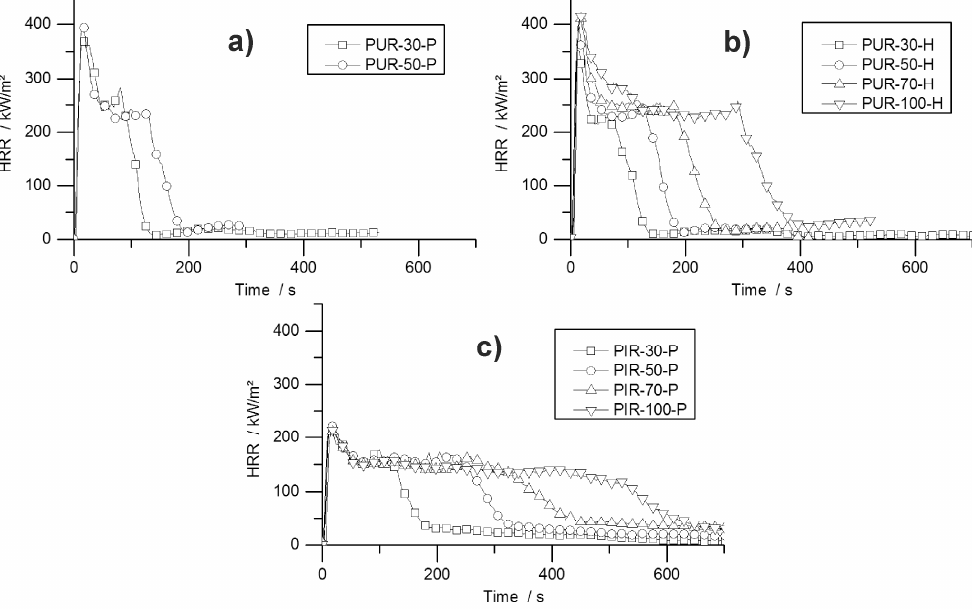
Figure 4. HRR curves for ( a ) pentane-blown PUR, ( b ) water-blown PUR, and ( c ) pentane-blown PIR foams.